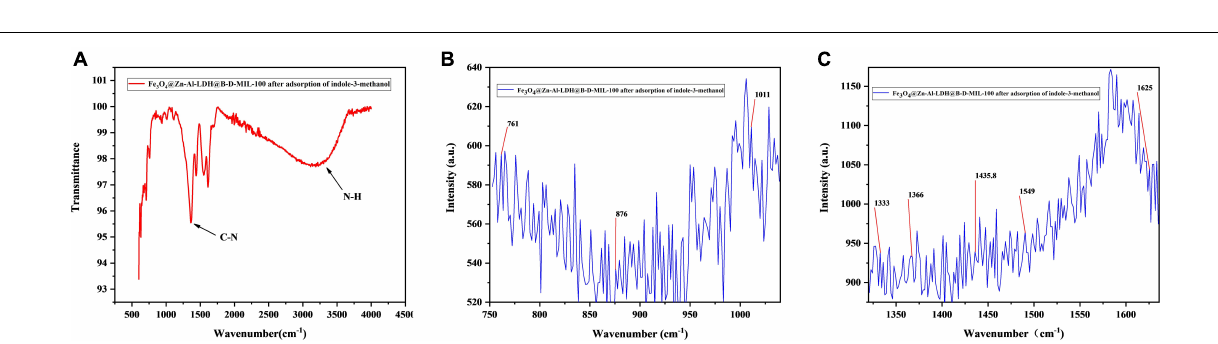
Frontiers in Nutrition |